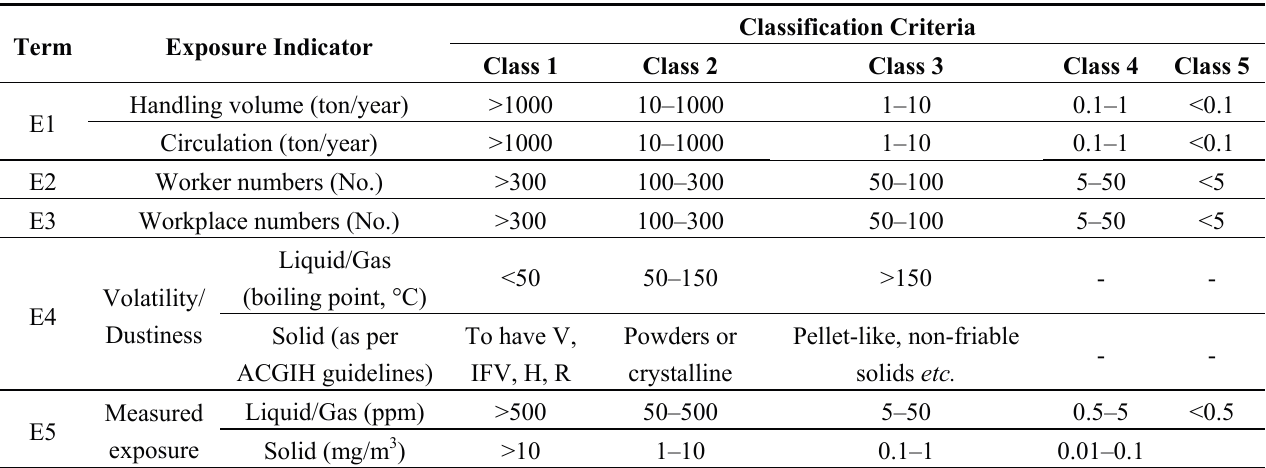
Table 3. Classification criteria for exposure